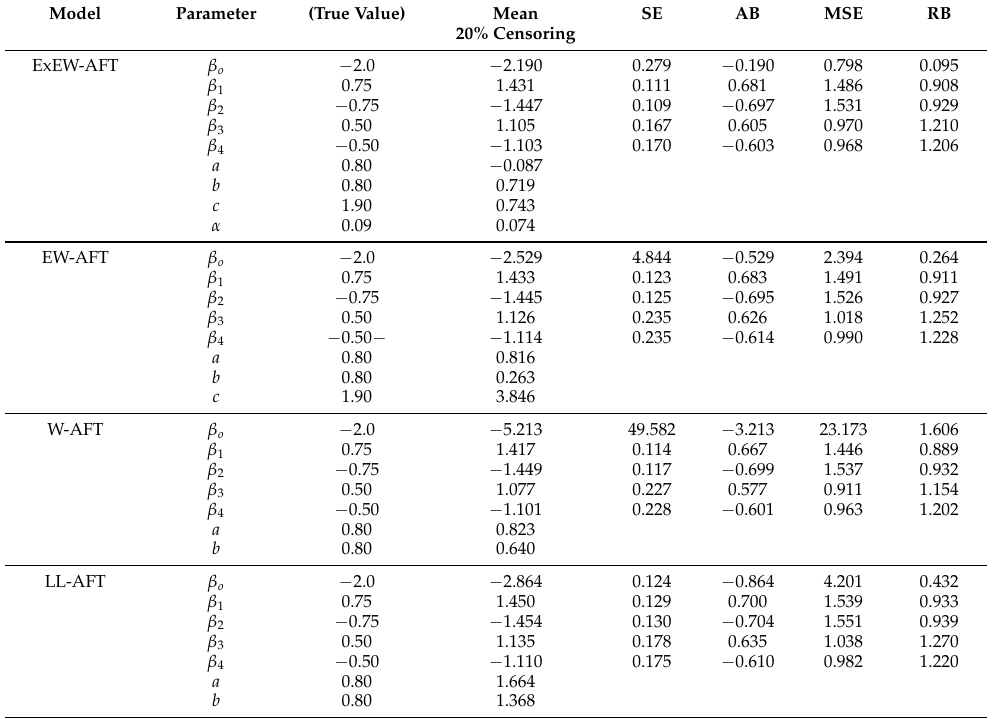
Table 6. Simulation study for scenario 2 ( n = 5000) with about 20% censored observations is used to compare model